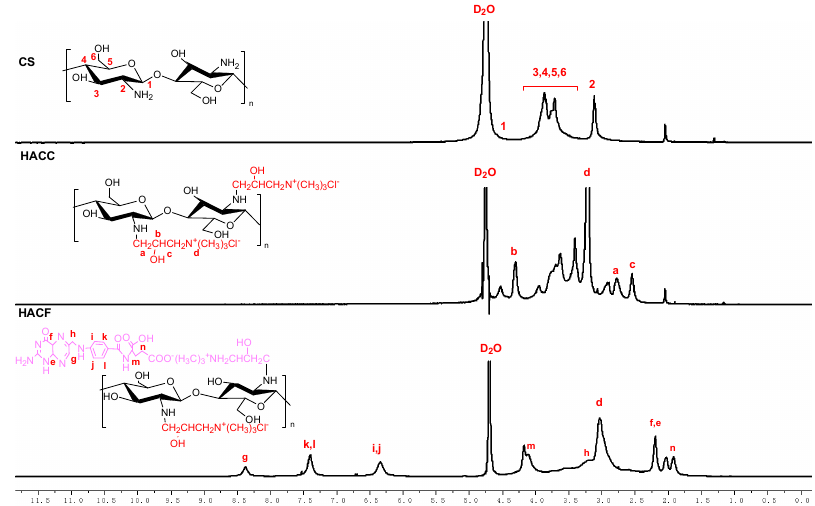
Figure 2. 1 H NMR spectra of chitosan and chitosan derivatives. Table 1. Yields and DS of chitosan